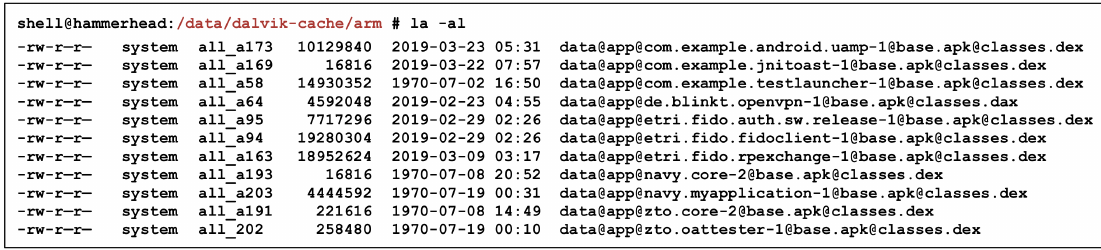
Figure 26. OAT file creation path on Android device.